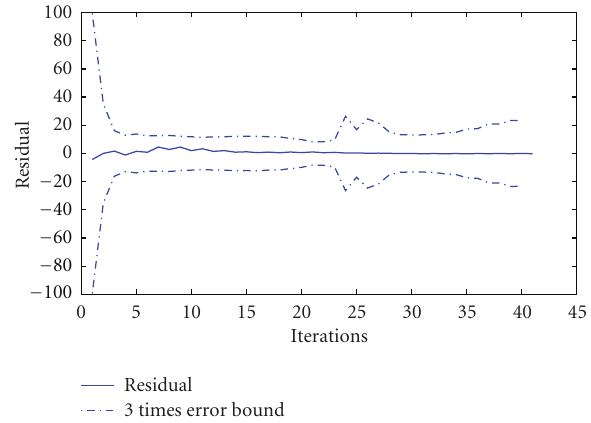
Figure 7: Comparison of EKF residual and the error covariance weighting.